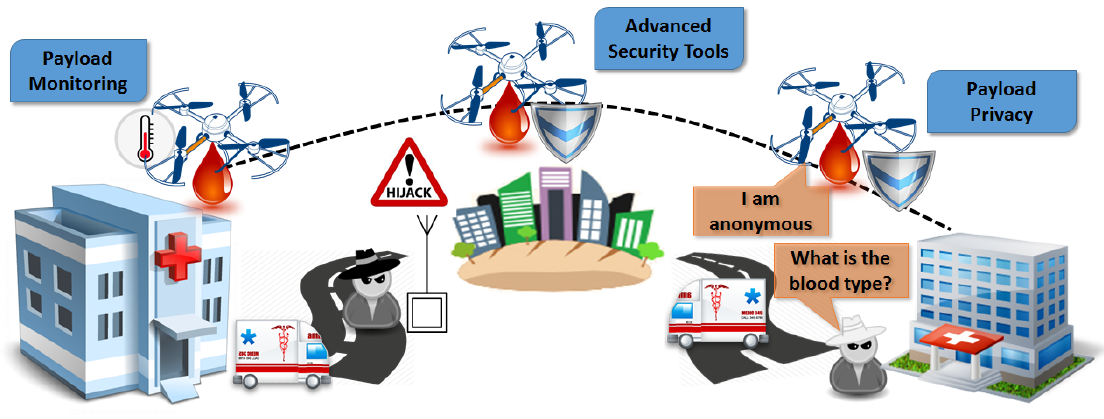
Figure 6. Human blood delivery